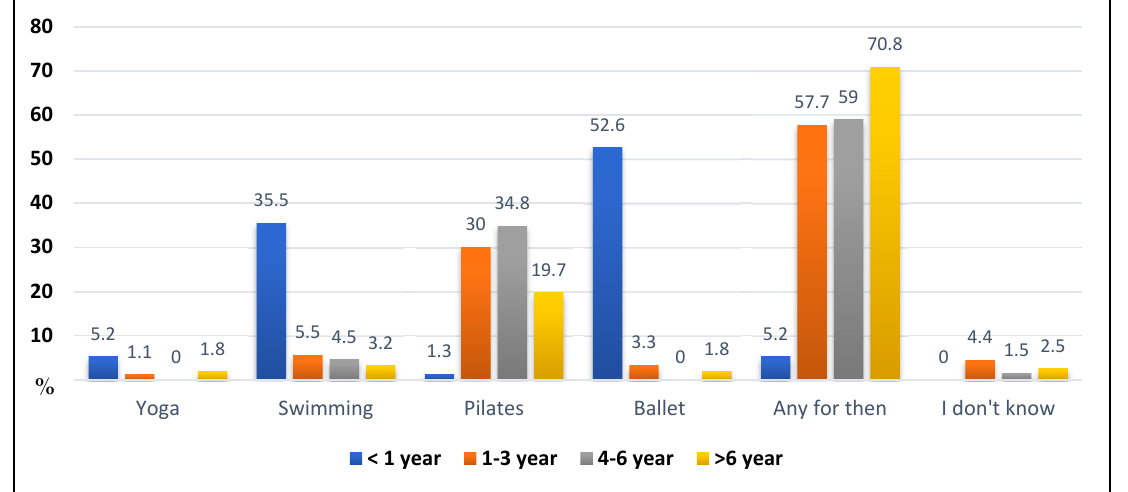
Figure 3. Opinions of the participants on physical activities that benefit patients with AIS.